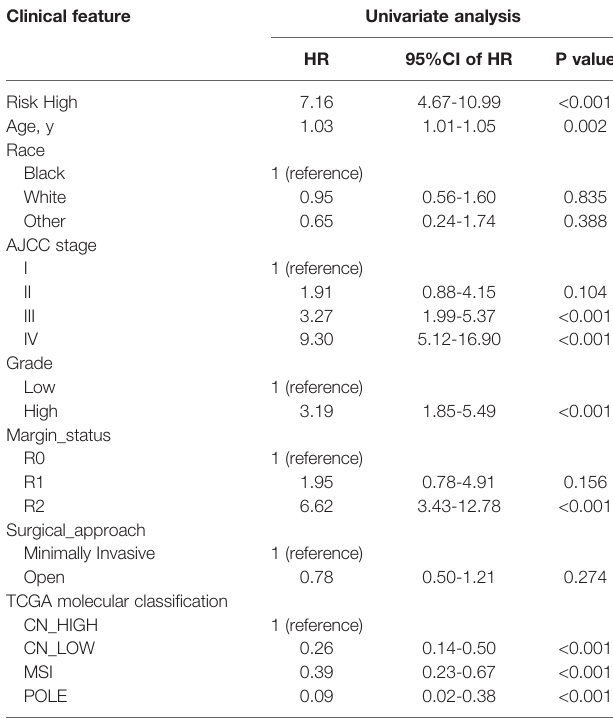
TABLE 2 | Univariate Cox regression analyses for identifying clinicopathological parameters related to EC patients ’ OS. Clinical